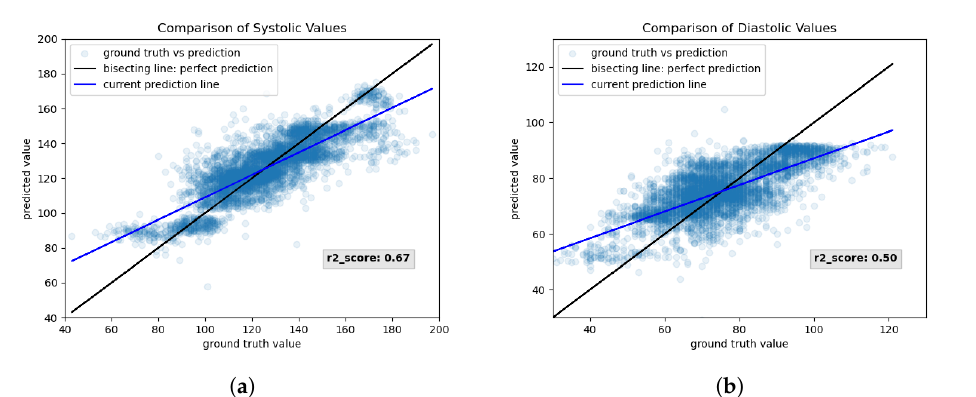
Figure 23. Results of training neural network with 25 input nodes, two hidden layers with 50 and 15 nodes, respectively, and 2 output nodes. Used correlation threshold for filtering: 0.8. Regularization: